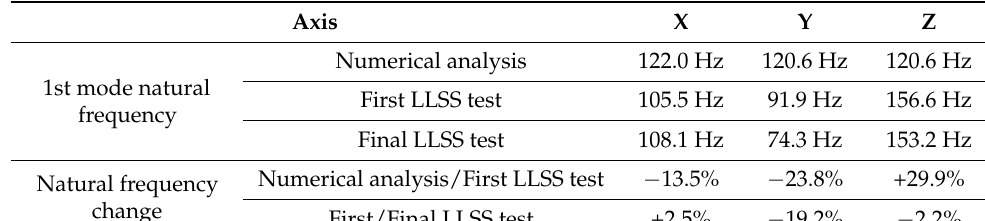
Table 8. Summary of the natural frequency on each axis of the Pumbaa.